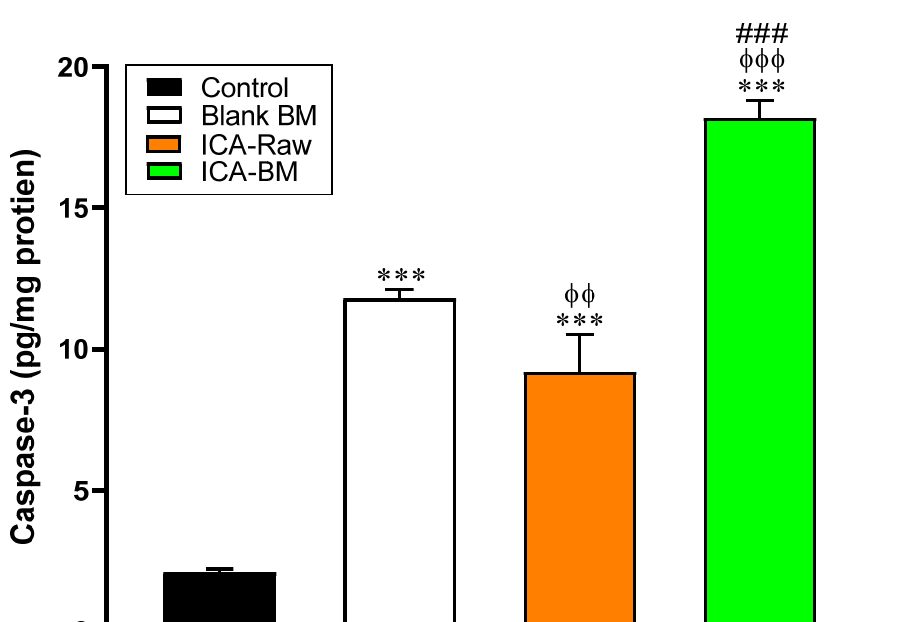
Figure 7. Effect of Blank BM, ICA-Raw, and ICA-BM treatments on caspase-3 enzyme content in PANC1 cells. Data are the mean of 4 independent experiments ± SD. *** Significantly different vs. Control ( p < 0.001); φφ Significantly different vs. Blank BM ( p < 0.01); φφφ Significantly different vs. Blank BM ( p < 0.001); ### Significantly different vs. ICA-Raw ( p < 0.001).